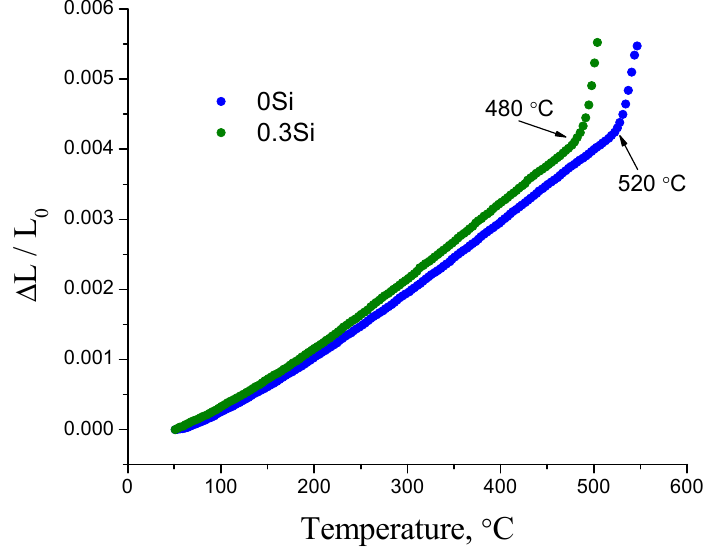
Figure 4. Thermal expansion dependences of 0Si and 0.3Si glasses.